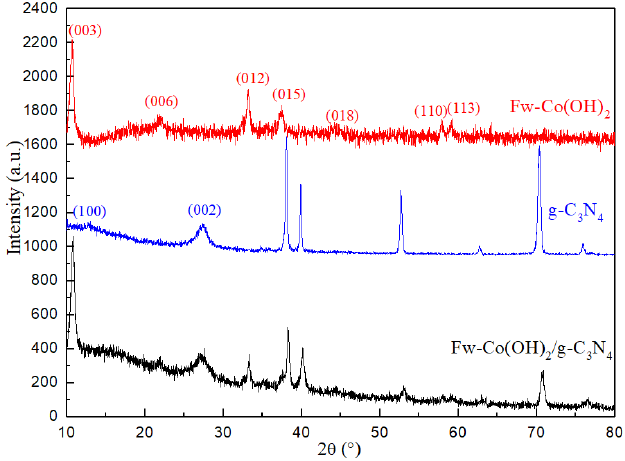
Figure 2. The XRD patterns of Fw-Co(OH) 2 , g-C 3 N 4 and Fw-Co(OH) 2 /g-C 3 N 4